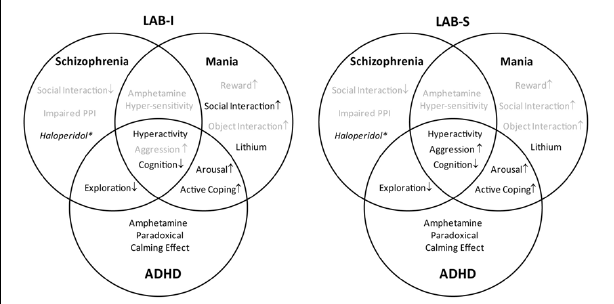
FIGURE 15 | Summary of the characteristics of LAB-I and LAB-S mice. LAB-I and LAB-S mice are validated to possess some characteristics which may mimic the behavioral symptoms (face validity) and pharmacoresponsiveness (predictive validity) of three different psychiatric disorders (highlighted in black). As the diagram demonstrates, both LAB subgroups mainly fulfill the criteria of a valid animal model of ADHD. ( ∗ Haloperidol treatment attenuated locomotor activity in all mouse